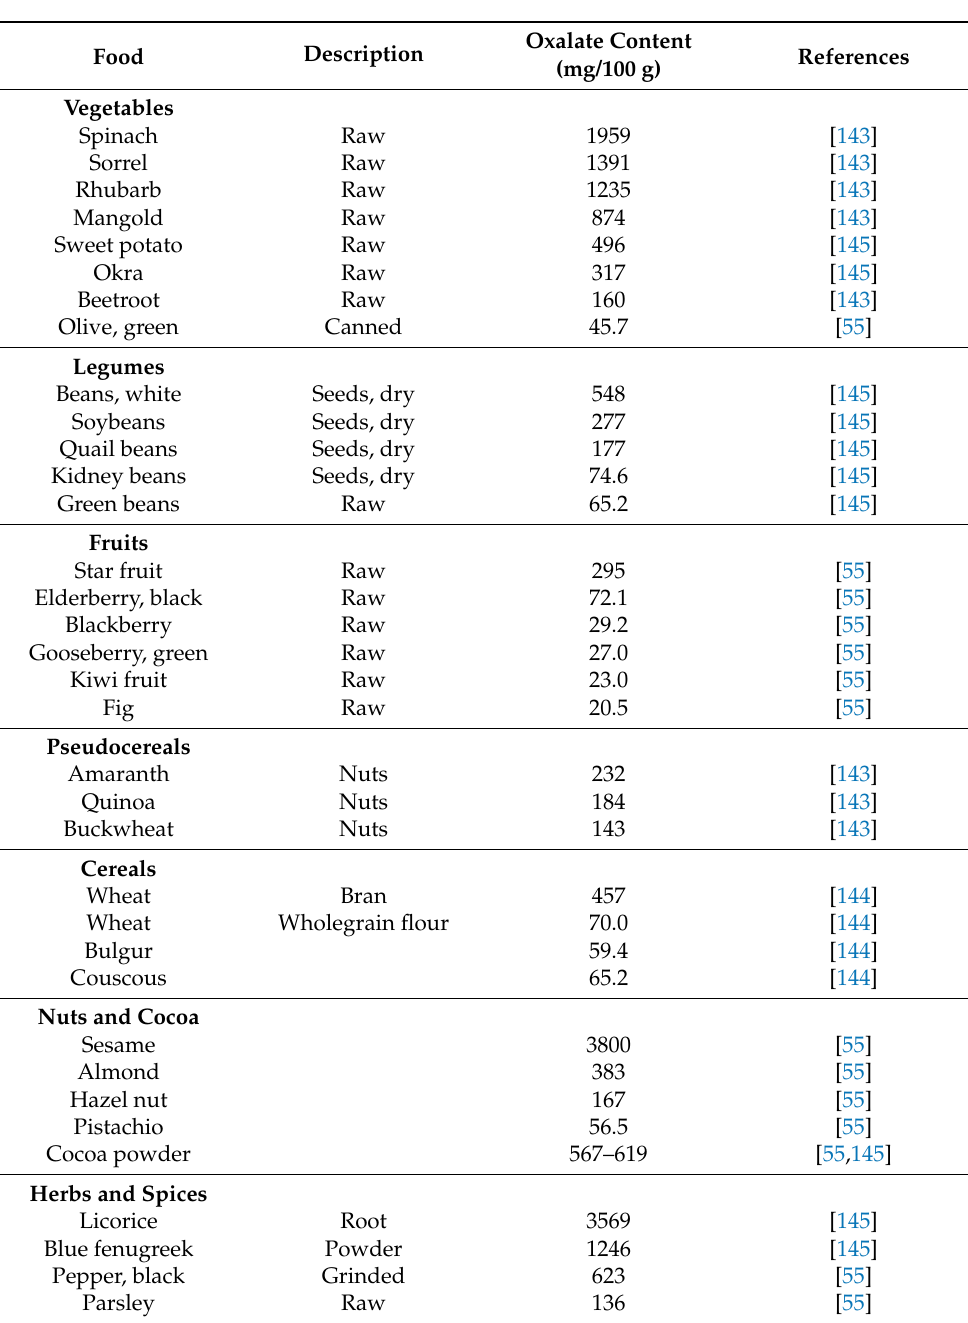
Table 3. Oxalate-rich